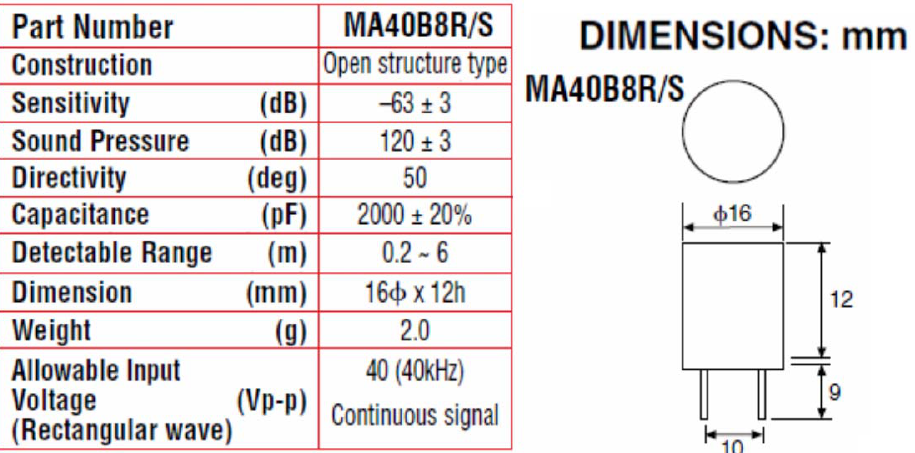
Figure 2. Specifications and dimensions of Murata Manufactoring Co., Ltd. 40 kHz emitter and receiver